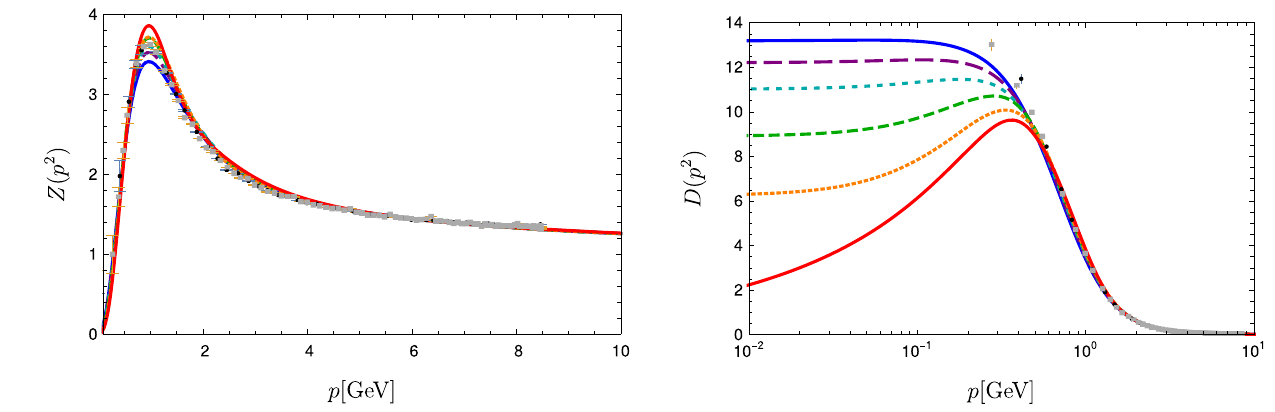
Fig. 3 Gluon dressing function Z ( p 2 ) (left) and gluon propagator D ( p 2 ) (right) in comparison to lattice data [52]. For the sake of com- parison, the functional results were renormalized to agree with the lat-